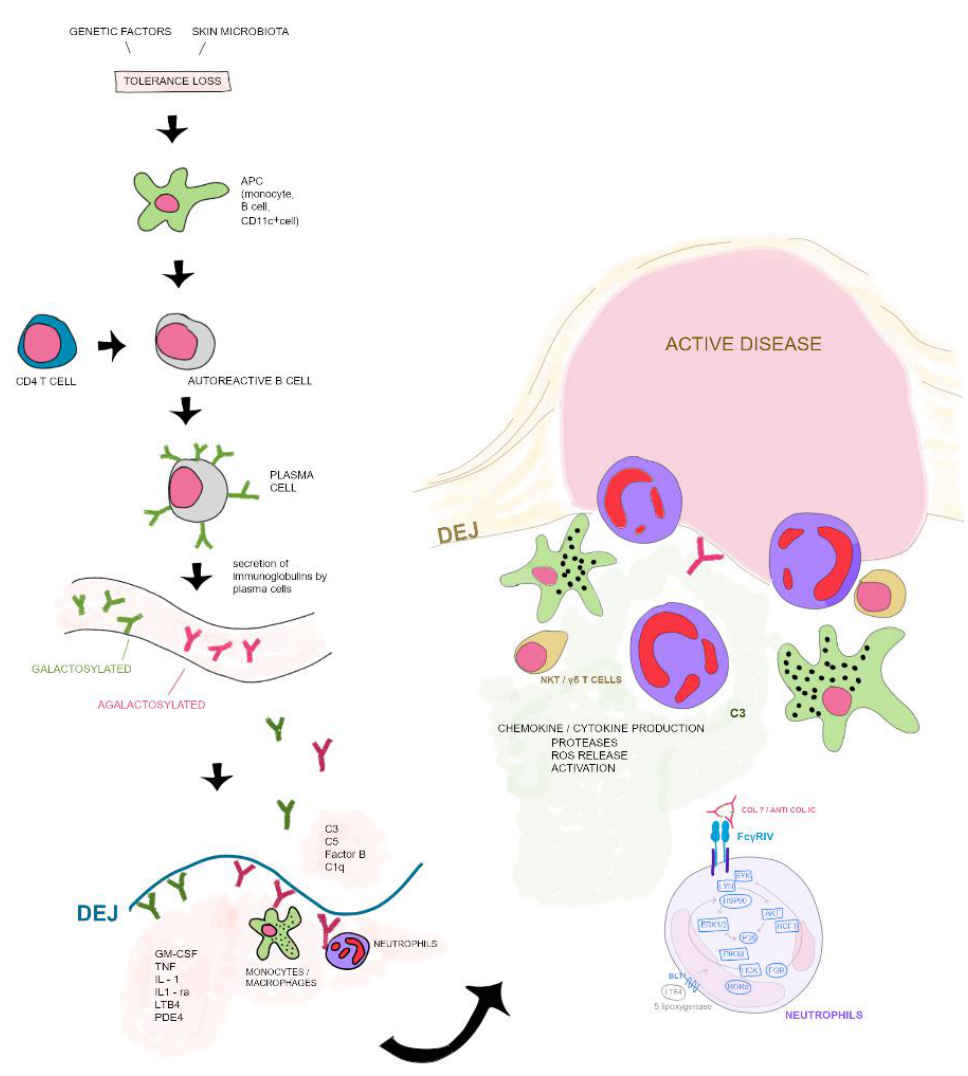
Figure 1. Pathogenesis pathway of EBA.